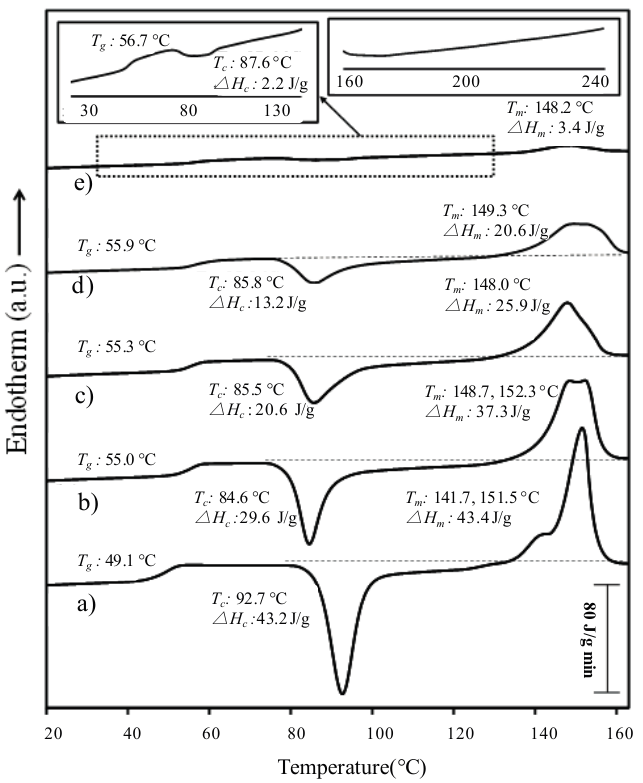
fractions were detected (see white circle and arrows). These aggregates could act as nucleating agents and should be occluded inside the spherulites due to covalent bonds between PPhe and PLLA blocks. Figure 11. Calorimetric curves of the third heating run (20 °C/min) of PLLA -NH ( a ) and 25 2 block copolymers with different chain length units, PLLA - b -PPhe ( b ); PLLA - b -PPhe ( c ); 25 5 25 13 - b -PPhe ( d ) and PLLA - b -PPhe ( e ). Insets show a magnification of the low PLLA 50 25 25 30 temperature region for PLLA - b -PPhe and the DSC trace recorded in the 160–245 °C 25 30 range for the PLLA - b -PPhe sample. 50 25